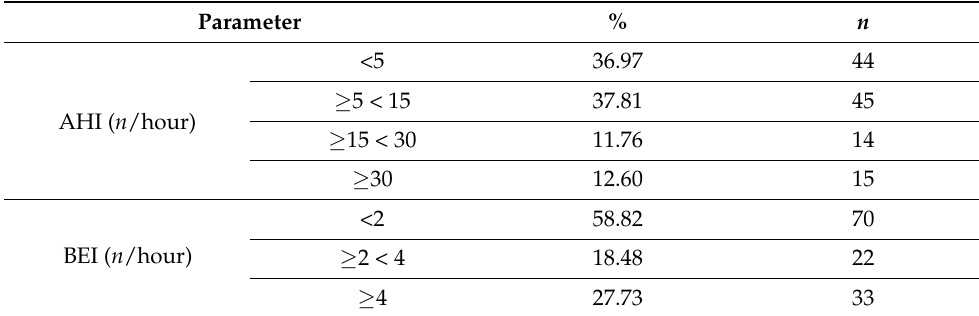
Table 2. The prevalence of obstructive sleep apnea and sleep bruxism in studied